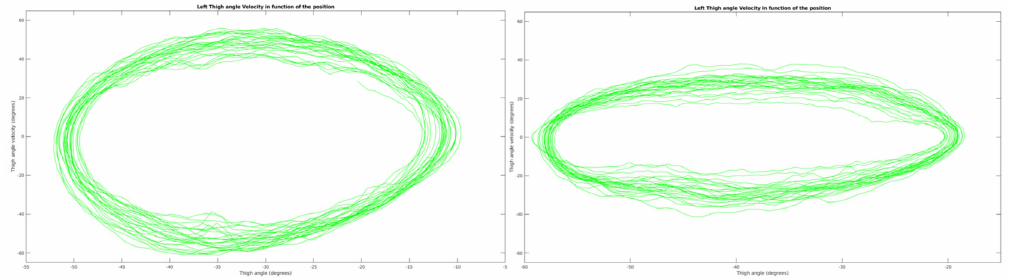
Figure 6. Representation of the left thigh angular velocity as a function of angular position. ( Left ) 27 cycles in stationary condition. ( Right ) 25 cycles in over-ground